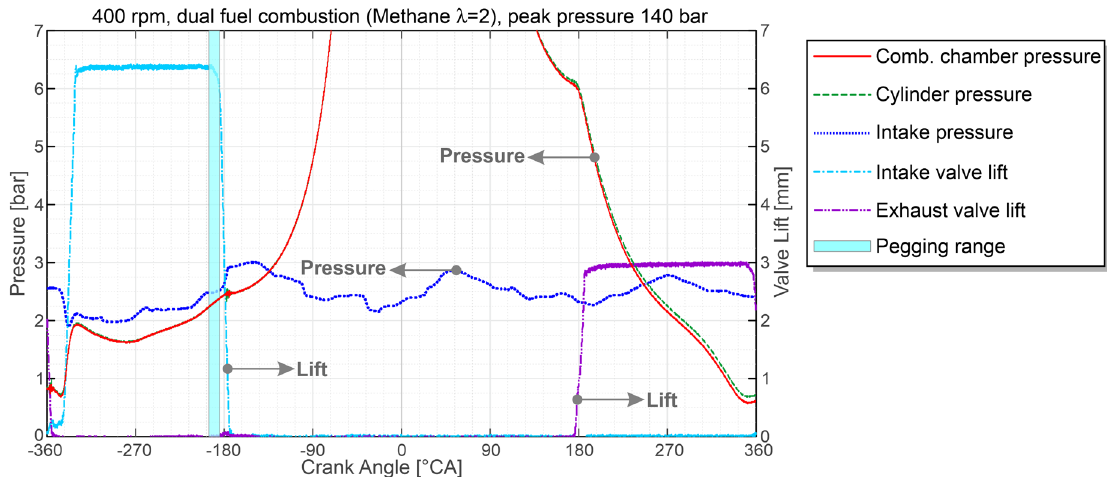
Figure 10. Pressure traces and valve lift curves for an experiment with combustion (400 rpm, premixed fuel methane λ = 2, pilot injection with dodecane, peak combustion pressure 140 bar). In the blue colored area (around –190 ◦ CA), the cylinder pressure can be pegged to the absolute intake pressure with the help of tabulated coe ffi